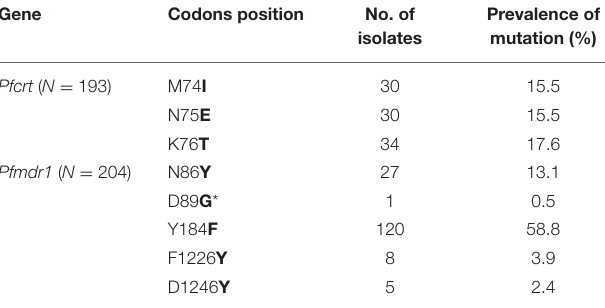
TABLE 3 | Polymorphisms of Pfcrt and Pfmdr1 in studied